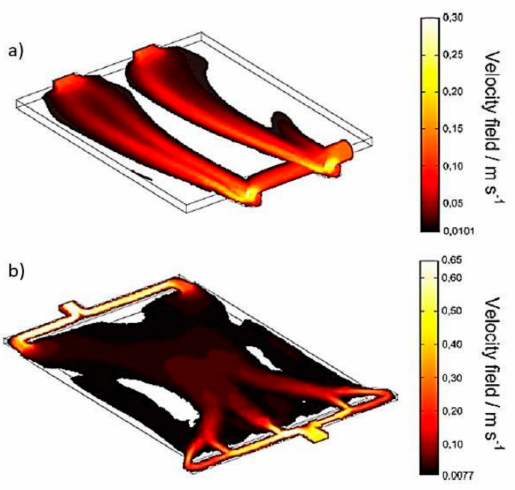
Figure 10. Inlet and outlet geometry: ( a ) common FM01-LC; ( b ) new design; ( c ) mass transfer distribution of tracer (adapted from Cruz-D í az et al. [23]).